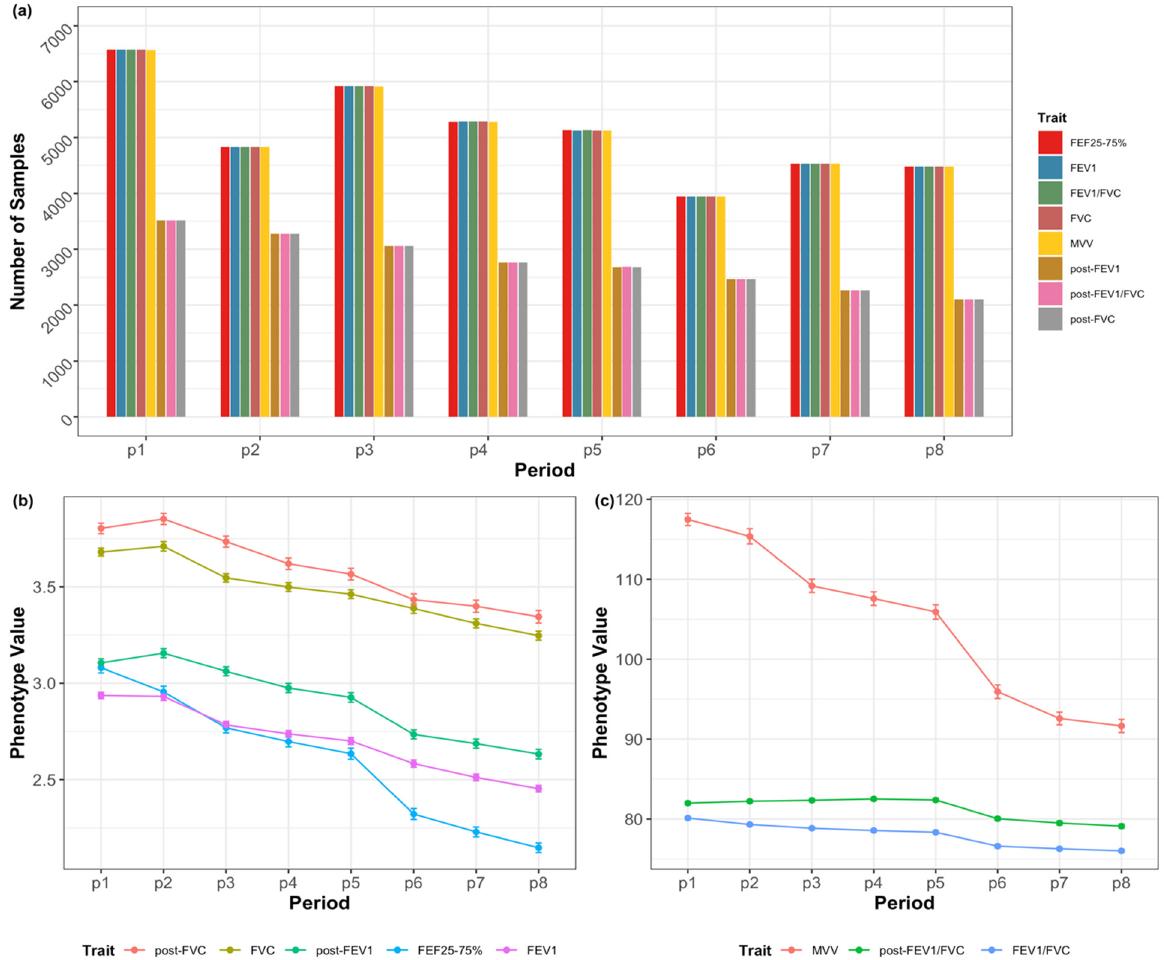
Figure 1. Number of samples used for analyzing the eight lung function traits and the mean observed values across eight periods. ( a ) Numbers of samples in each period (p1–p8). ( b , c ) Profile plot of the mean values of the eight traits in each period. Since the ranges of the traits differed, they are presented as two separate plots. FVC, forced vital capacity; FEV 1 , forced expiratory volume in 1 sec; FEV 1 /FVC, forced expiratory volume in 1 s to forced vital capacity ratio; FEF 25–75%, the average forced expiratory flow during the mid (25–75%) portion of the FVC; MVV, maximal voluntary ventilation; post-FVC, post-bronchodilator test for FVC; post-FEV 1 , post-bronchodilator test for FEV 1 ; post- FEV 1 /FVC, post-bronchodilator test for FEV 1 / FVC ratio. The statistical analyses required estimates of the mean and annual change rates for each subject, for which we included 6622 participants (3569 Ansan and 3053 Ansung) who were followed up ≥ 3 times (Table 1). Since some of the participants had a missing smoking status, 5104 participants were analysed in the smoking-related studies (3009 never-smokers and 2095 ever-smokers). In addition, 3,352,722 SNPs were considered in the analysis after quality control and